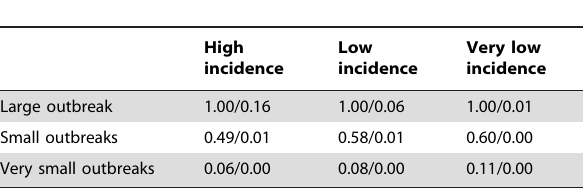
Table 1. Median of sensitivity/false positive rate of assigning locally infected cases to a putative transmission cluster for simulated